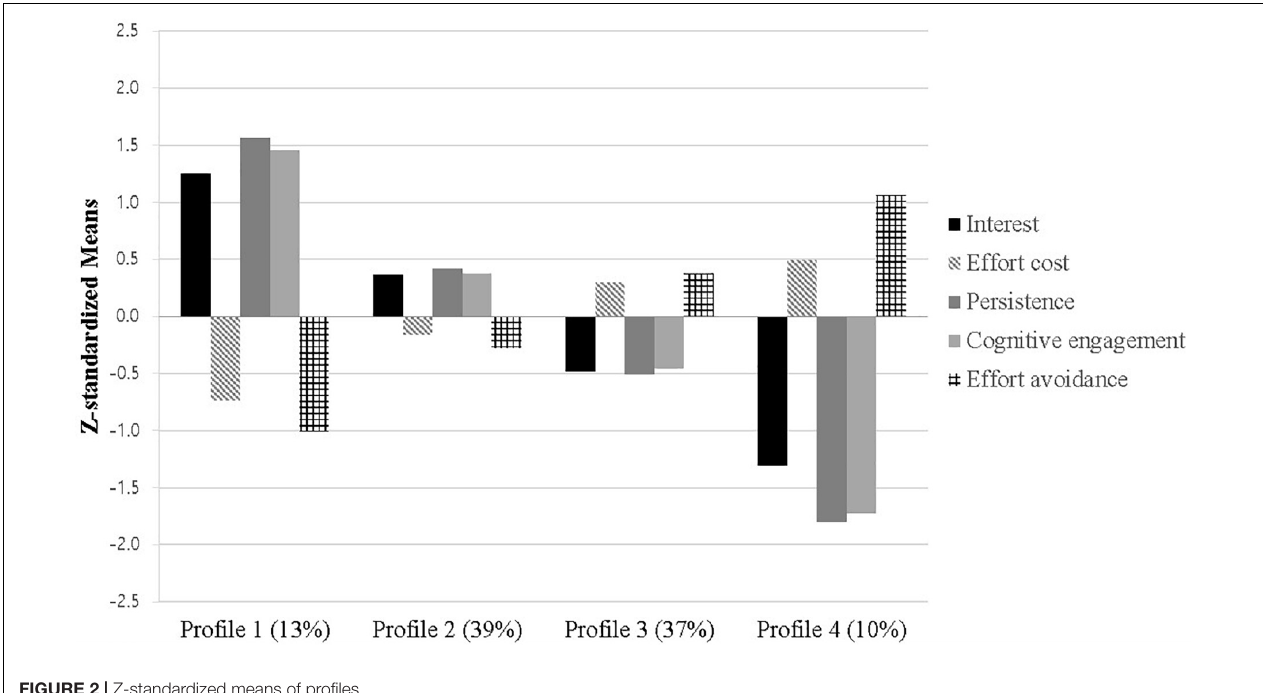
FIGURE 2 | Z-standardized means of profiles. TABLE 3 | Results from SEM and multi-group analysis. Whole Female